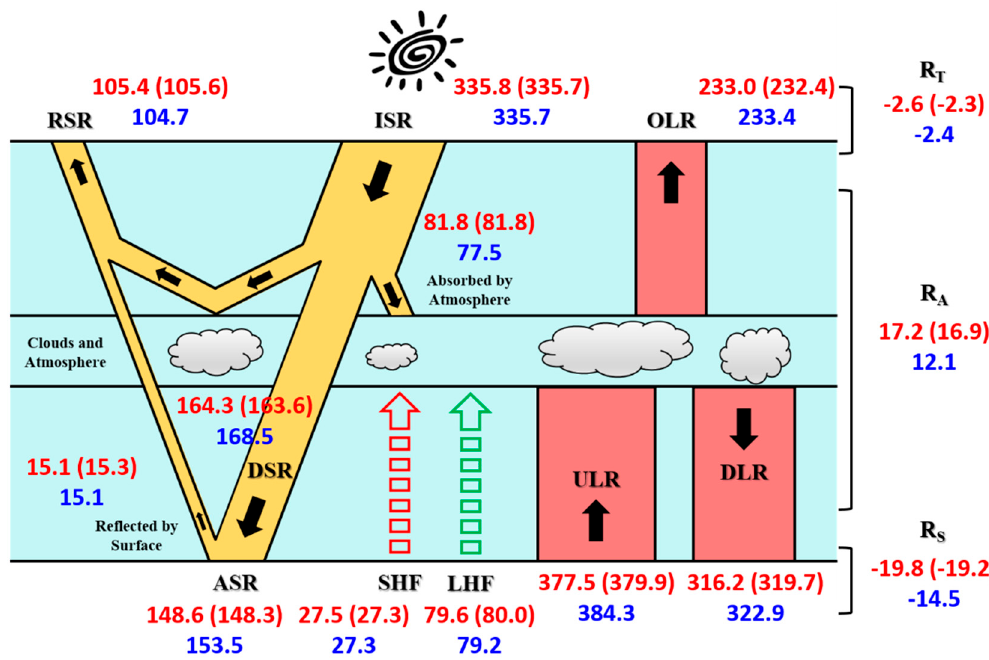
Figure 10. Annual mean radiation components and energy budget of the Korean Peninsula region in 2016. Red: Radiation components and energy budget calculated using CERES and MERRA-2 data (values in parentheses are the results of analyzing only 350 days of data used in this study); Blue: radiation components and energy budget calculated in this study.